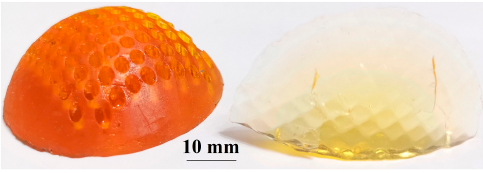
Figure 4. 3D-printed objects prepared with Irgacure 784 ( left ) and BFC ( right ). Reproduced with permission of Ref. [221].